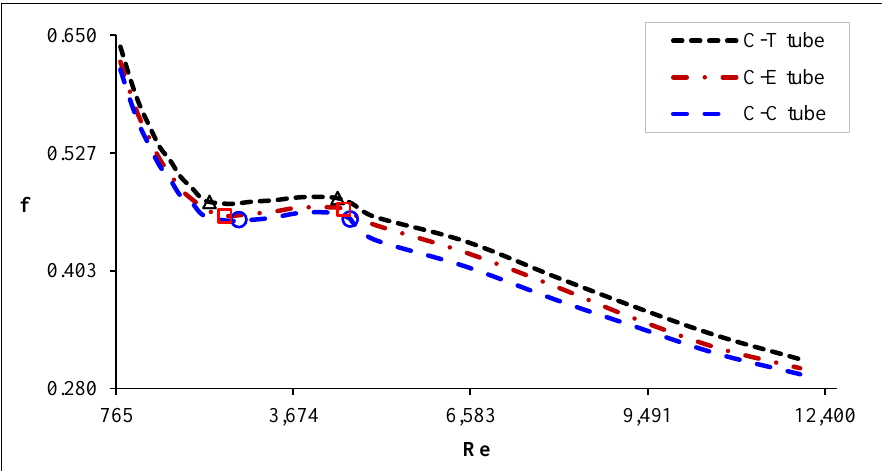
Figure 8. Friction factor for the flows in the